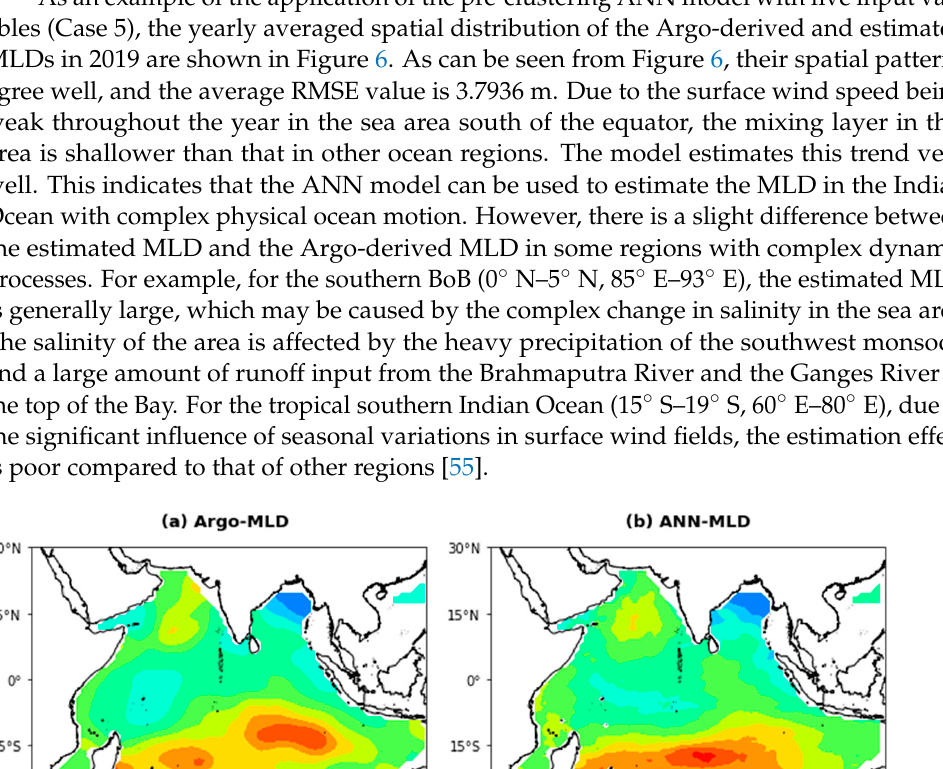
Table 4. The RMSE and R 2 values of Case 1 to Case 5.